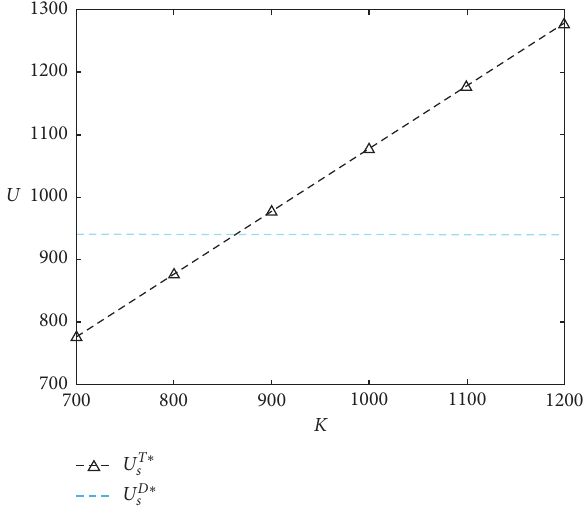
Figure 10: The effect of compensation on supplier utility.